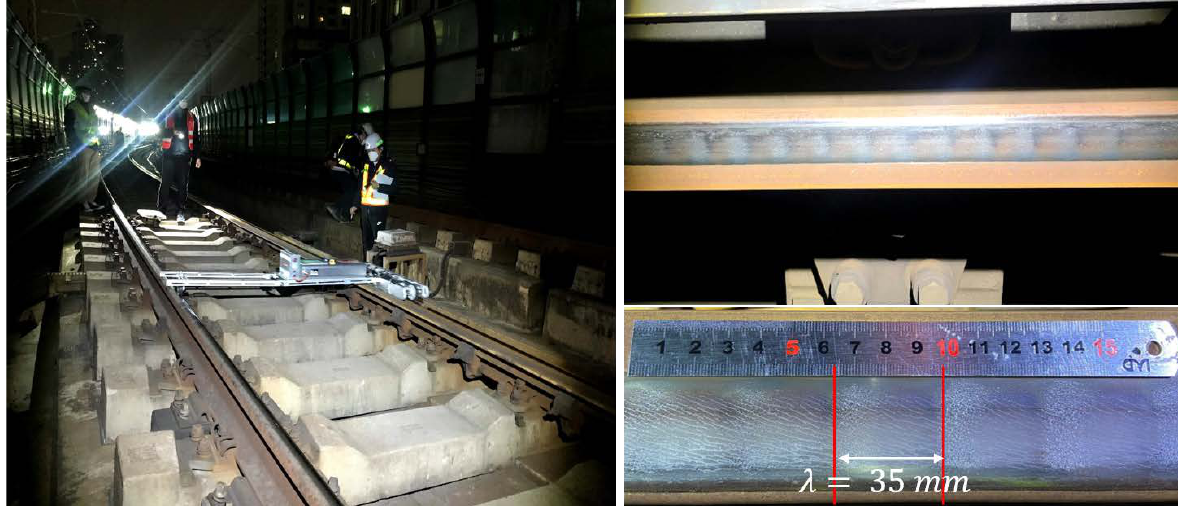
Figure 6. Field|measurement of corrugated rail on curved